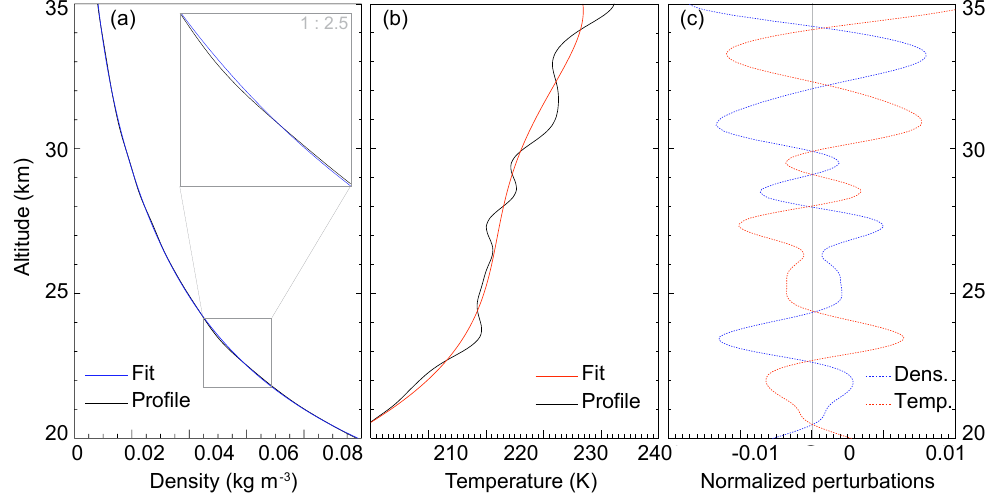
Figure 1. Example profile, background fit for density (a) and temperature (b) , and normalized perturbations (c)